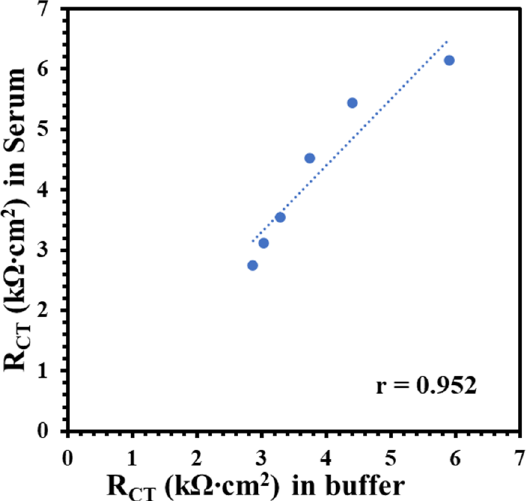
Figure 3. Correlation plot between R CT of synthetic Nf-L targets in commercial human serum with the R CT obtained in 1× PBS buffer. Pearson correlation coefficient r = 0.952 shows high correlation between target signals obtained in these two media.